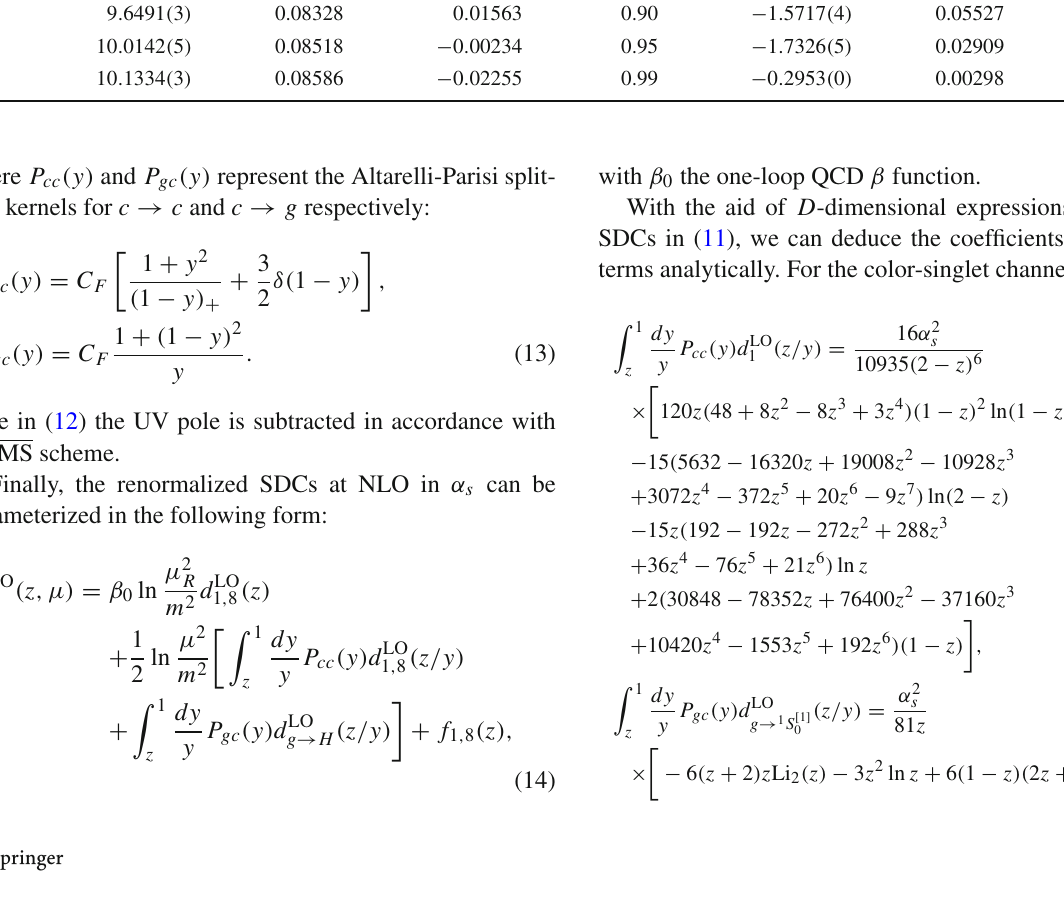
Table 2 Numerical values of non-logarithmic color-octet coefficient functions c ( 1 )